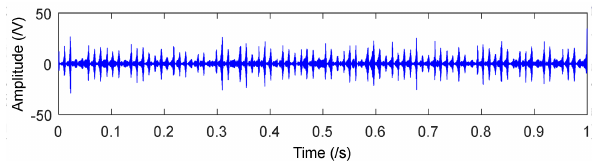
Figure 24. The time waveform after noise reduction.